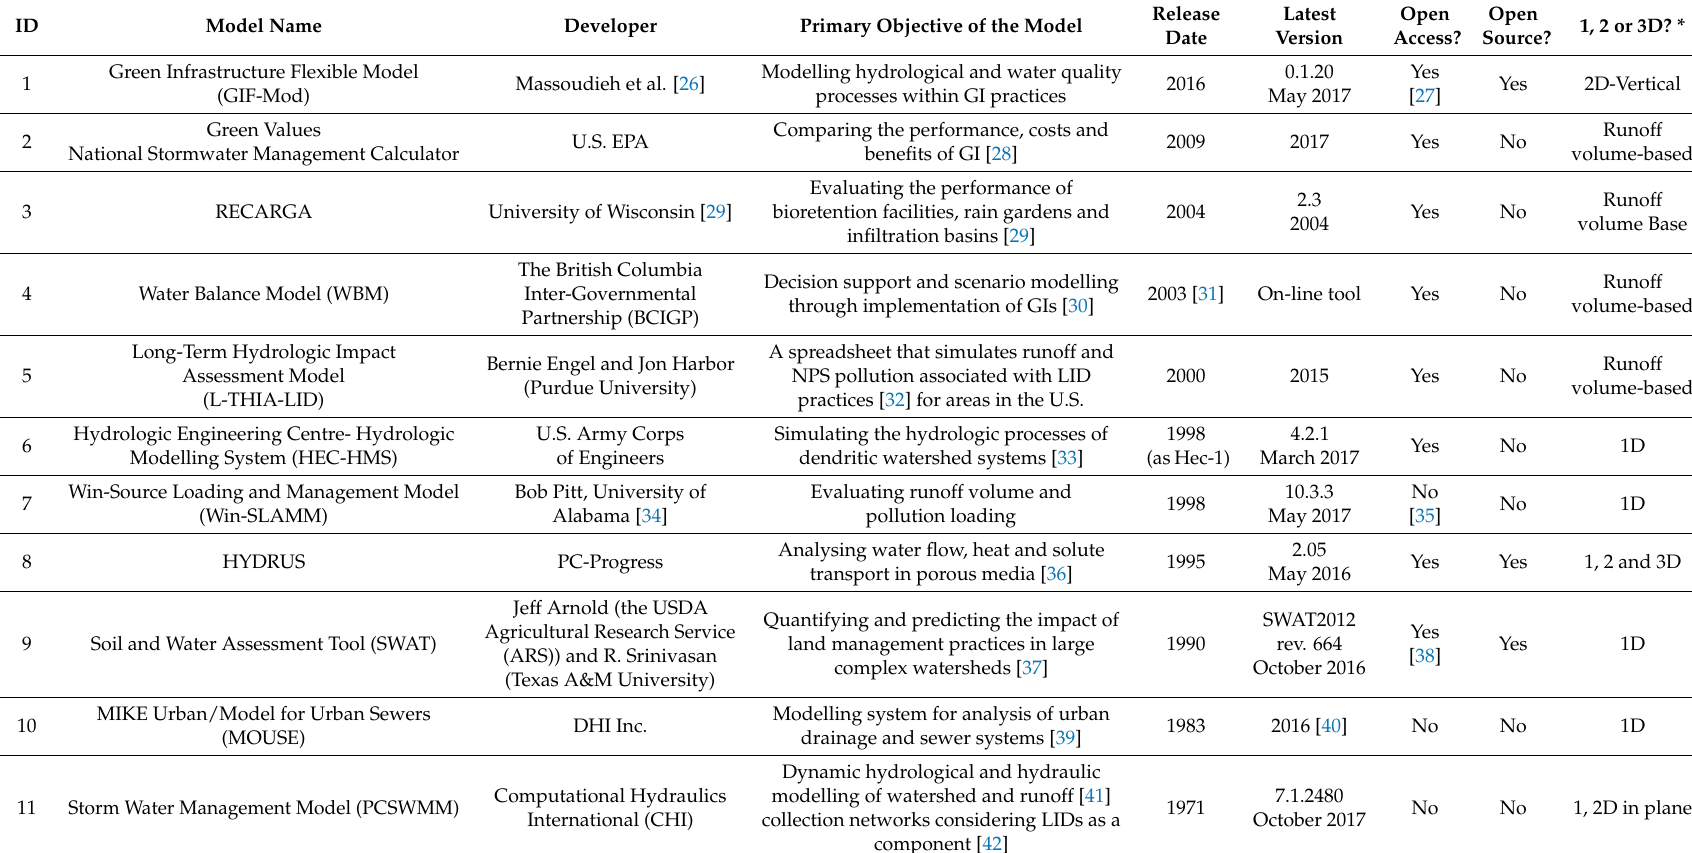
Table 1. Brief introduction to the selected